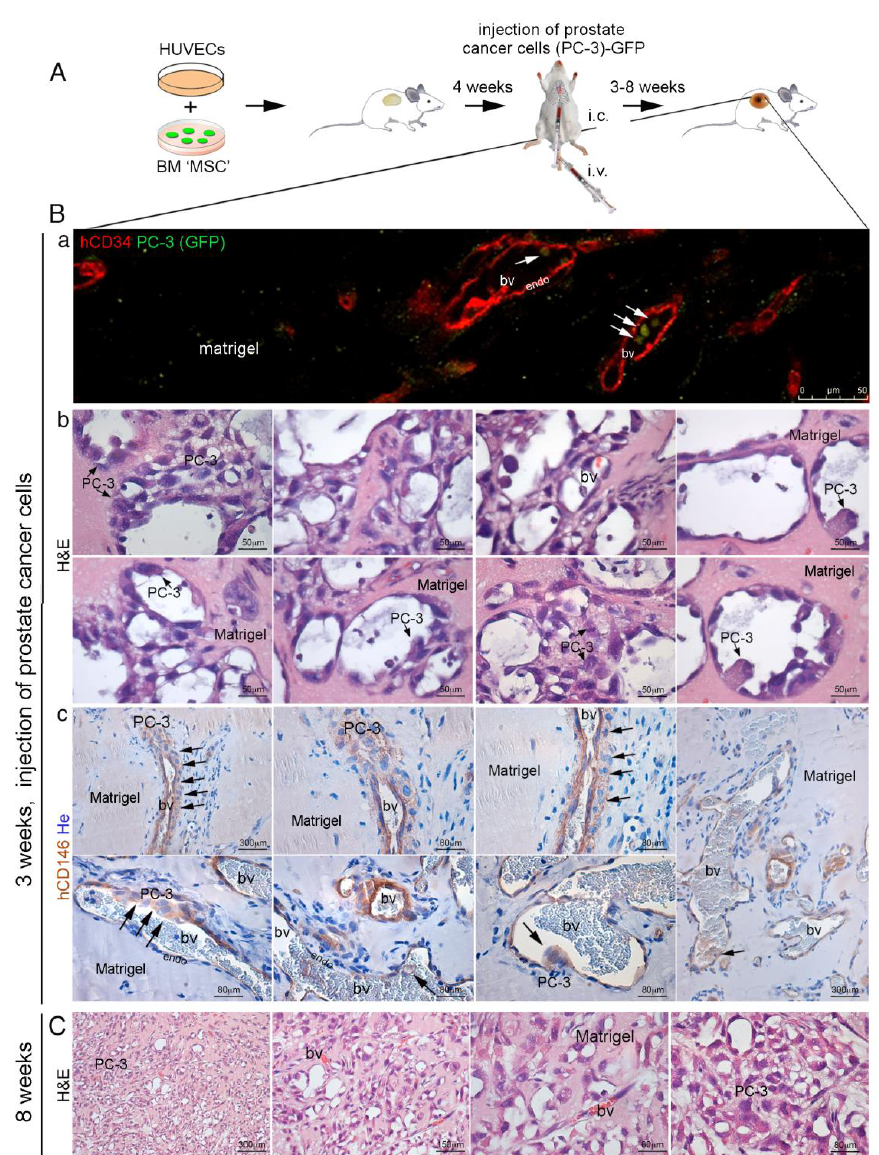
Figure 8. ( A ) in vivo heterotopic co-transplants of hBMSCs in Matrigel TM with HUVECs and injection of PC-3 cells; ( B ) implants generated by hBMSCs and HUVECs in Matrigel TM e ffi ciently formed functional blood vessels in 3–4 weeks. At this time, PC-3 cells were blood-injected in SCID / beige mice. Cancer cells colonized the implants generating metastasis. (a) representative images of implants (hBMSCs / HUVECs in Matrigel TM ) harvested at 3–4 weeks after injection of PC-3 cells; (b) co-transplants of hBMSCs in Matrigel with HUVECs generated an extensive functional network of capillary-like blood vessels (bv), as indicated by blood host perfusion, in the presence of red blood cells (RBCs). These vessels were composed by two cell layers: an inner continuous hCD34 + endothelial layer (endo), coated by an outer subluminal, thin, discontinuous layer of hCD146 + mural cells. In many instances, the blood vessels were coated with a multilayer of hCD146 + PC-3 cells, wrapped around the outer surface of vessels or near vessels in association with the layer of hCD146 + mural cells as demonstrated by hCD146 immunostaining and hematoxylin counterstaining. Early metastatic PC-3 cell clusters were regularly associated with blood vessels. (c) By fluorescence microscopy, single GFP-labeled PC-3 cells could be observed inside blood vessels; ( C ) co-transplants of hBMSCs in Matrigel TM along with HUVECs resulted in the formation of extensive metastases after eight weeks from i.c. injected PC3 cells, as demonstrated by H&E staining. H&E, Hematoxylin / Eosin; bv, blood vessels; RBCs, red blood cells; endo, endothelial cells. He, Hematoxylin counterstaining. Scale bar = 50, 80, 150, 300 µ